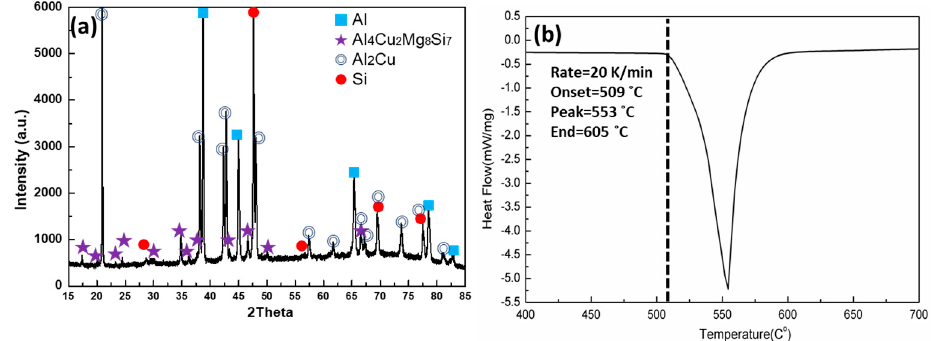
Figure 2. ( a ) XRD spectrum of Al − Cu − Si − Mg eutectic alloy ( b ) DSC curve of Al − Cu − Si − Mg eutectic alloy with a heating rate of 20 K/min.